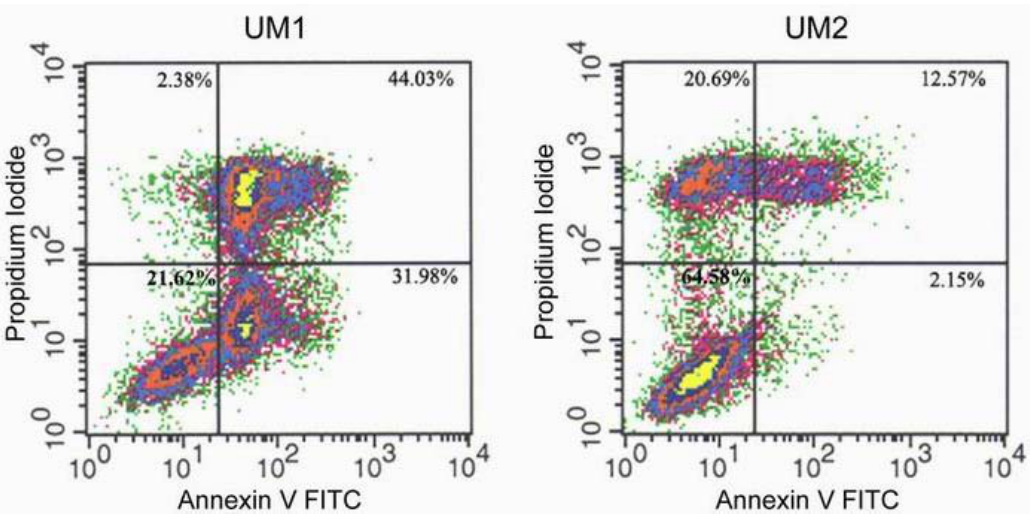
Figure 2. Flow cytometric analysis of TS -induced HOSCC cell death. UM1, UM2,